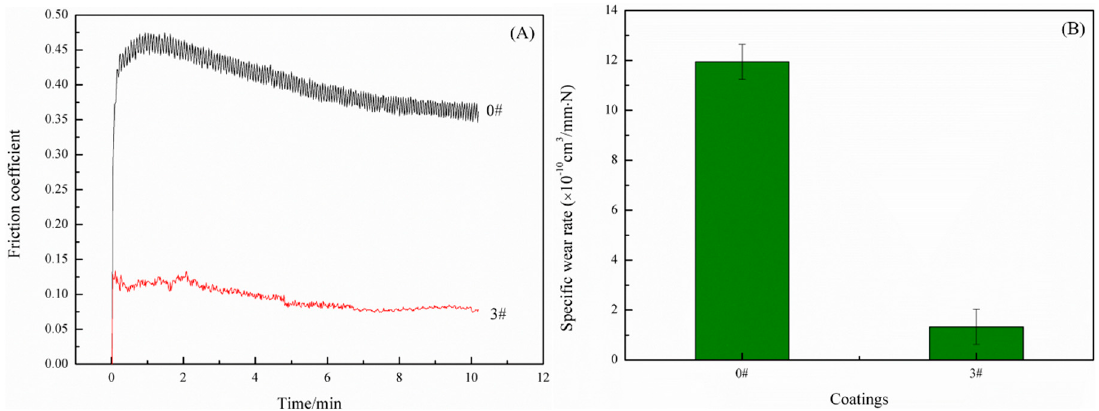
Figure 7. ( A ) Friction coefficient–time curves and ( B ) wear rates of #0 and #3 SHWPUC.